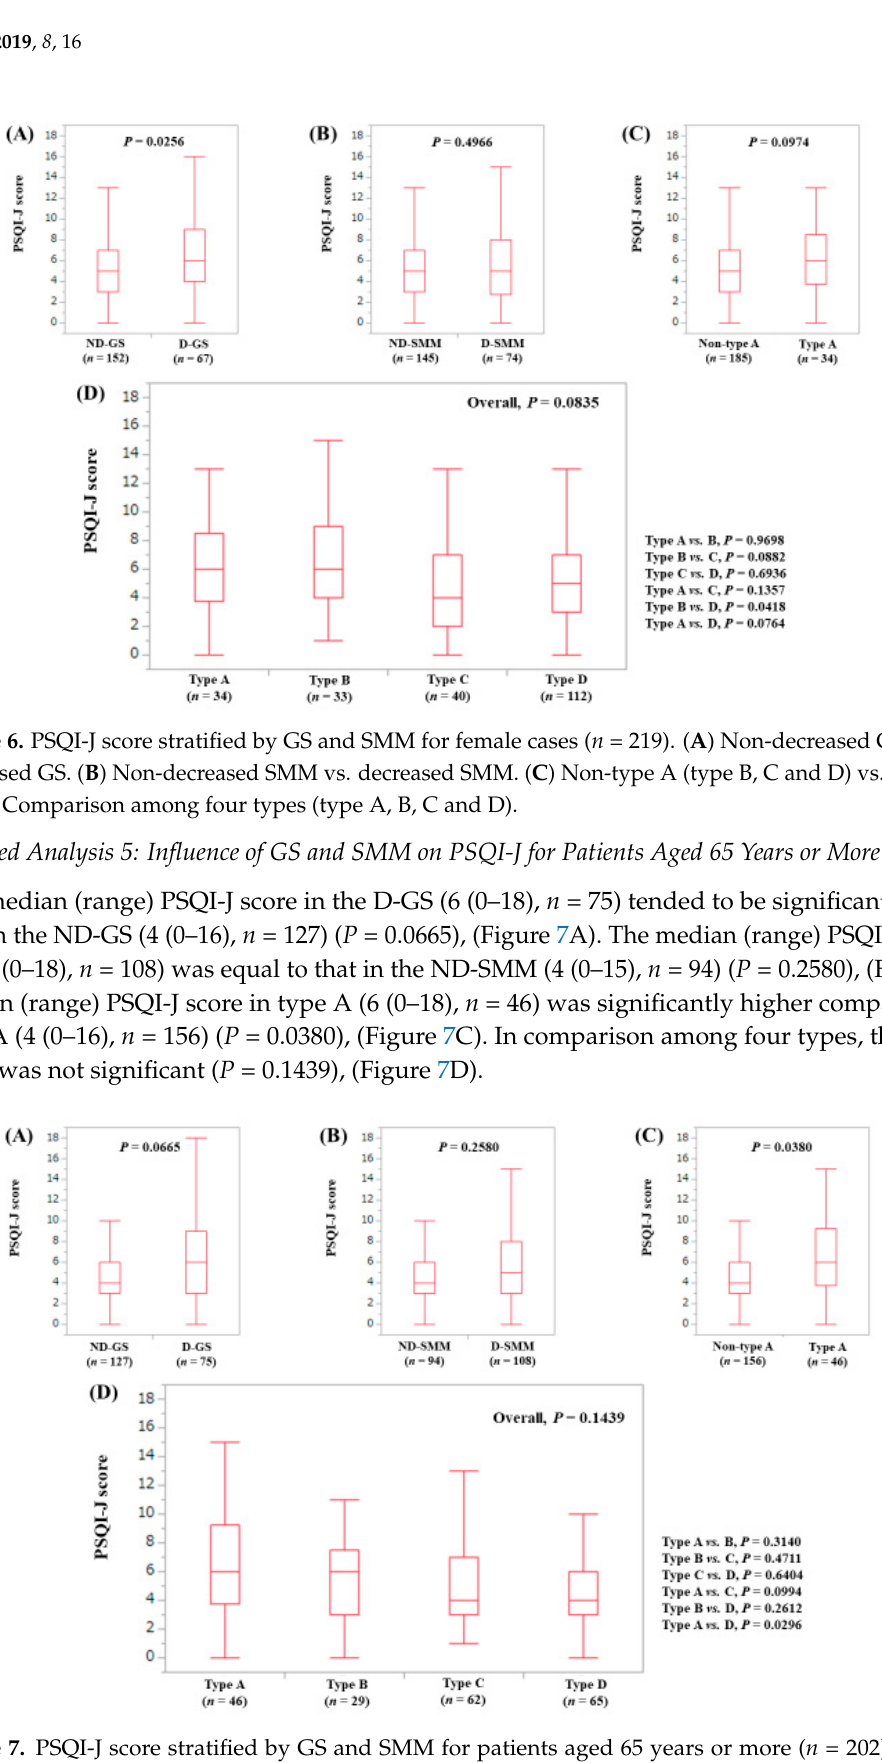
Figure 7. PSQI-J score stratified by GS and SMM for patients aged 65 years or more ( n = 202). ( A ) Non-decreased GS vs. decreased GS. ( B ) Non-decreased SMM vs. decreased SMM. ( C ) Non-type A (type B, C and D) vs. type A. ( D ) Comparison among four types (type A, B, C and D).